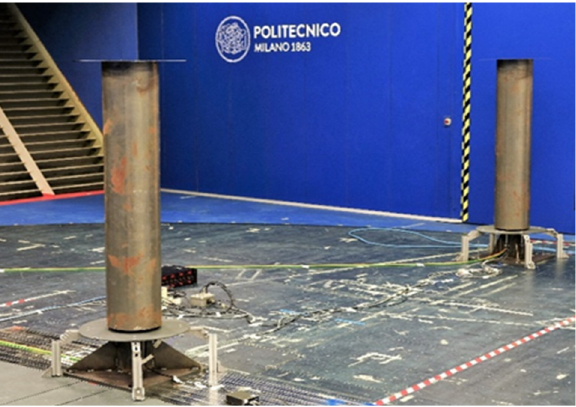
Figure 8. Rotors in a 15D distance configuration during the wind tunnel.